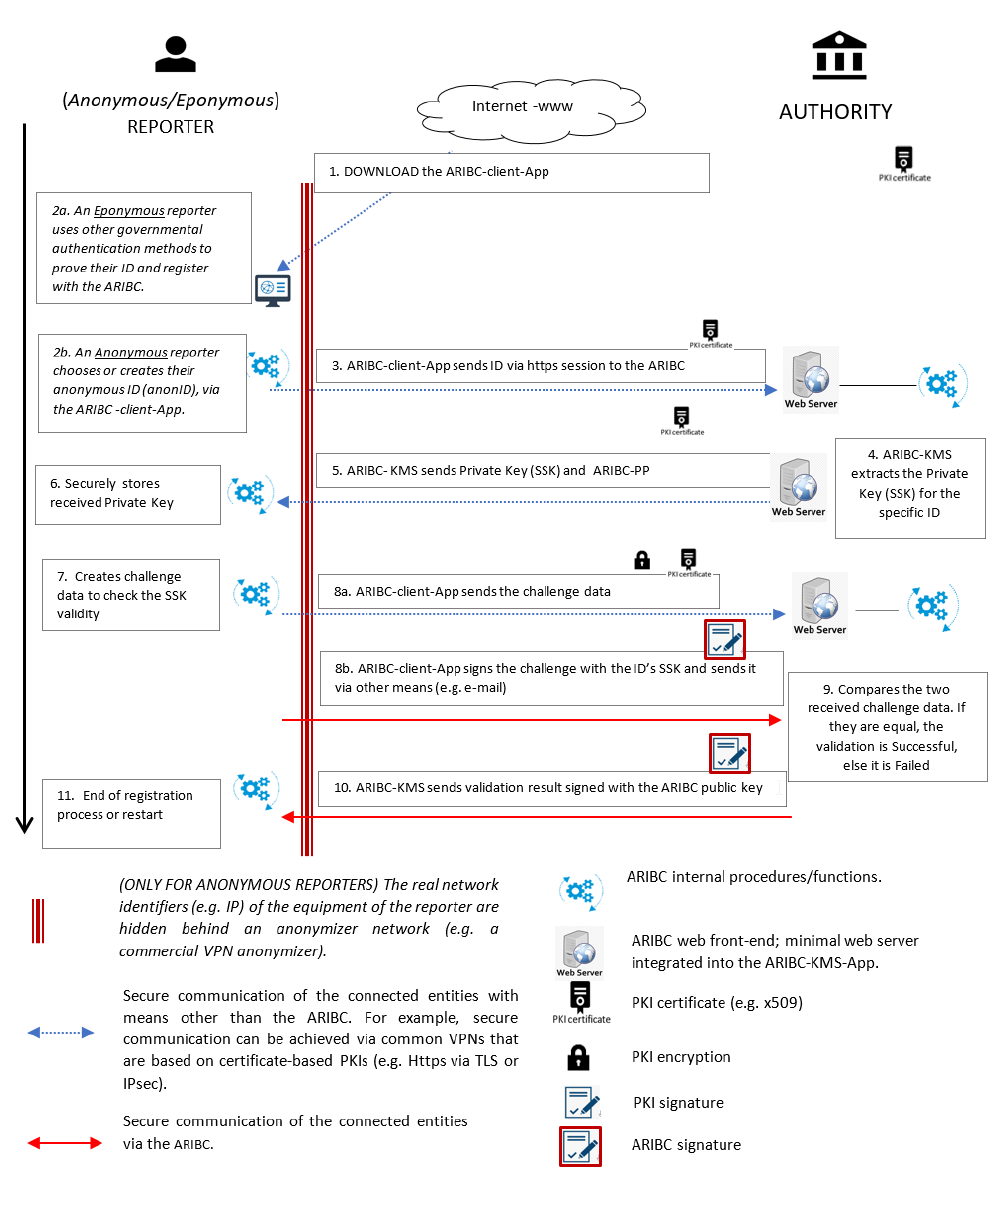
Figure 2. ARIBC user registration